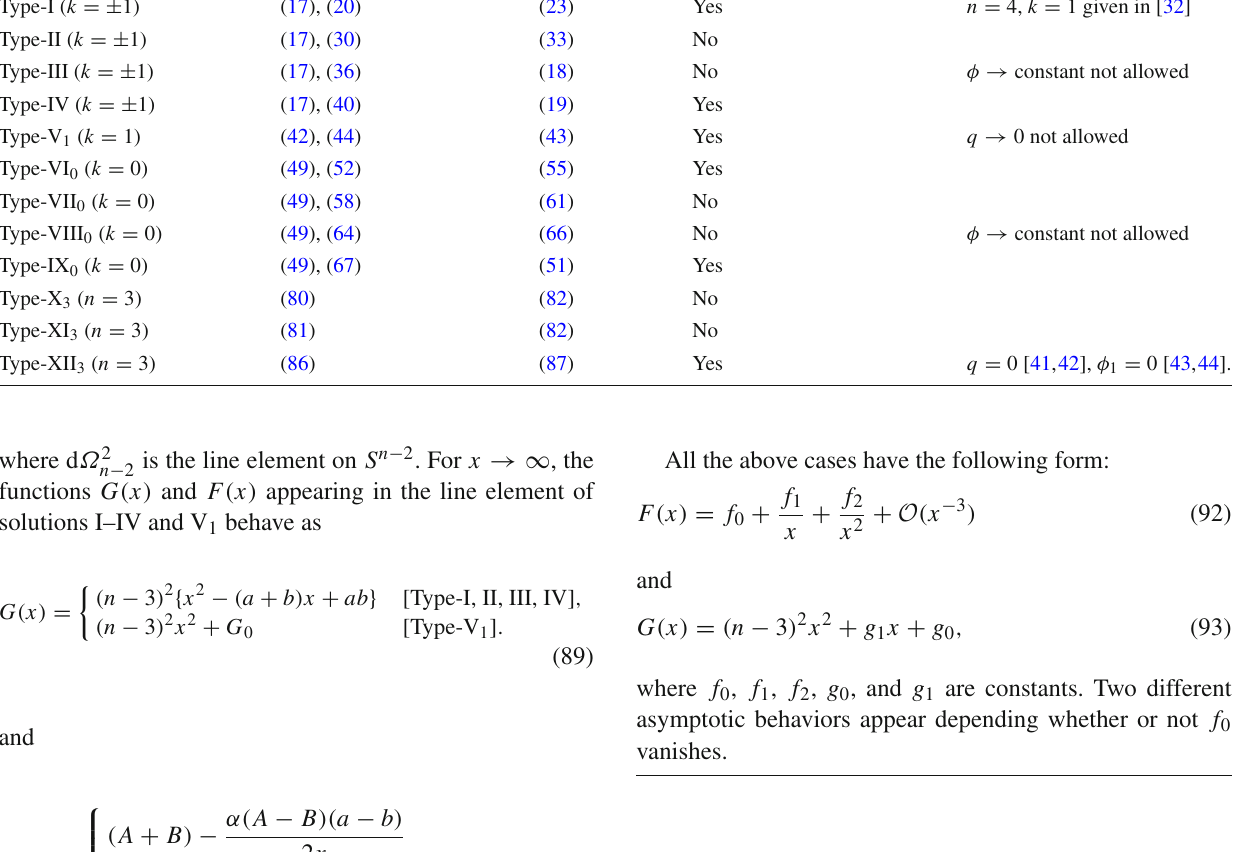
where q necessarily reduces to zero in the solutions II, IV, VII 0 , IX 0 , XI 3 , and X 3 . The term “phantom” in the table means a configuration where the scalar field φ is pure